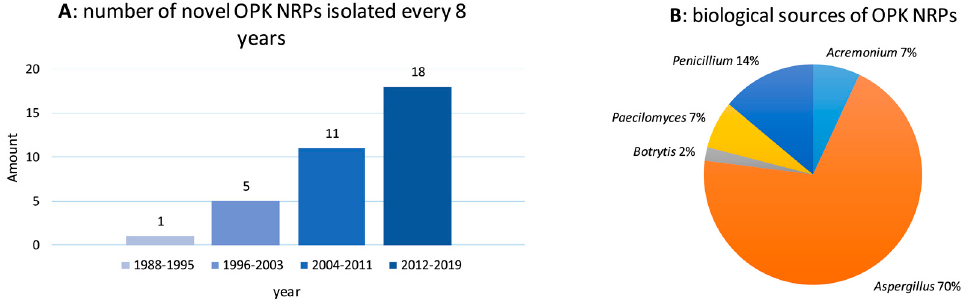
Figure 2. ( A ) number of novel Oxepine-Pyrimidinone-Ketopiperazine NRPs isolated every eight years, ( B ) biological sources of OPK NRPs at the genera level.